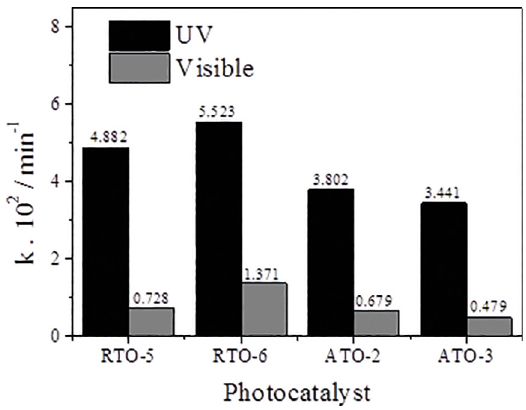
Figure 9. Pseudo-first order rate constants for the photocatalysts showing the best RNO decoloration performance (250 mg of catalyst; initial concentration of RNO = 2.0 x 10 -5 mol L -1